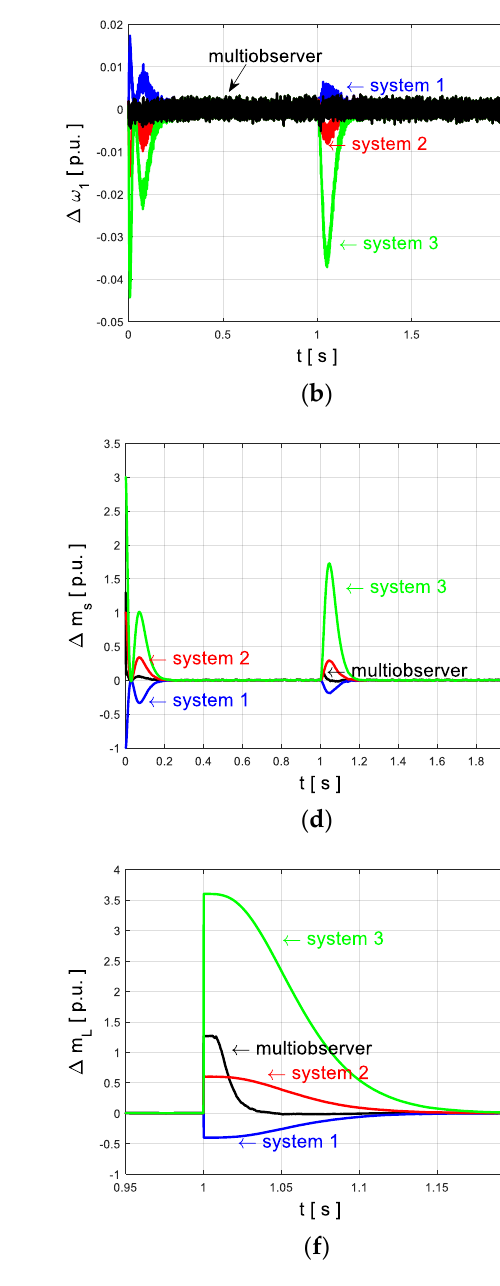
Figure 5. Transients of the observer’s weights α ( a ) and estimation errors for: motor ( b ) and load speeds ( c ), shaft ( d ) and load torques ( e ) and fragments of load torque ( f ) for multilayer observer working in open-loop system, first version – simulation.